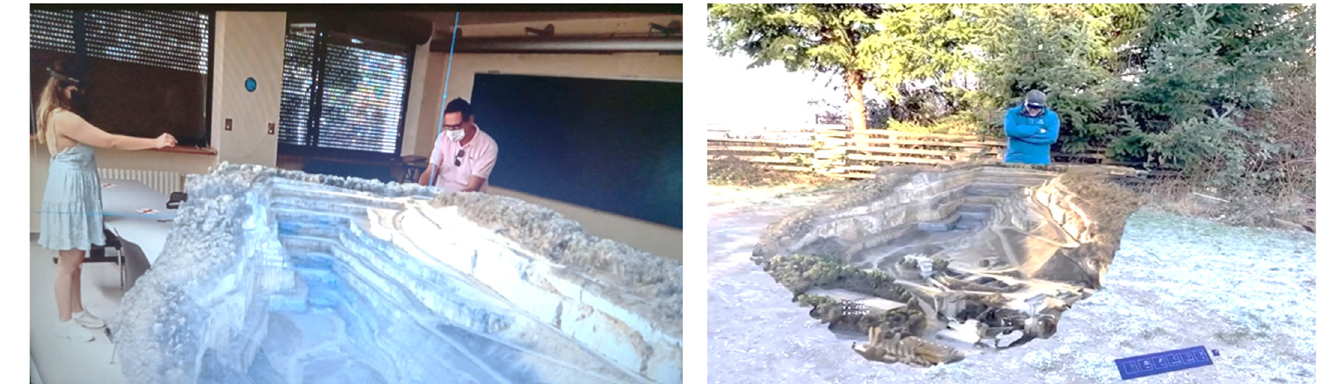
Figure 9. An open pit mine 3D hologram in MR. ( Left ) sharing the model in the classroom at the university. ( Right ) the model opened in the field for inspection and direct comparison with the real environment (pictures courtesy of UPC and BGC).